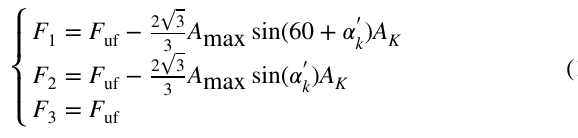
Fig. 15 Steering and pad forces when 270 < α